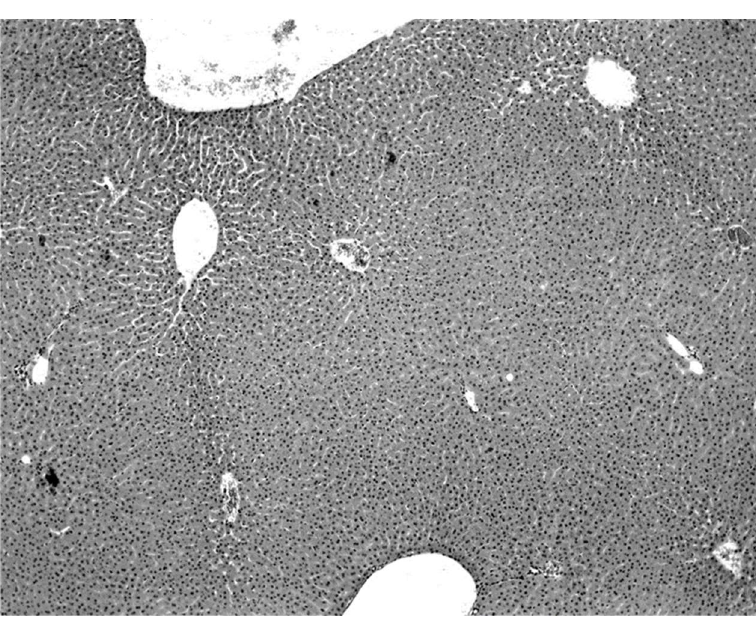
Figure 3. Normal liver of a KKV-negative naturally moribund free-tailed bat.